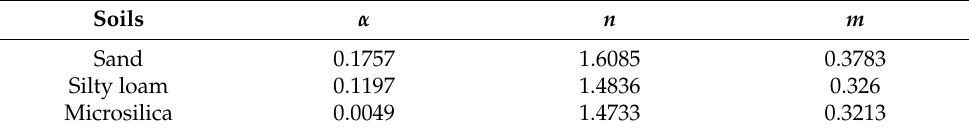
Table 3. Fitting VG parameters of soil-water characteristic curves of three kinds of soils.